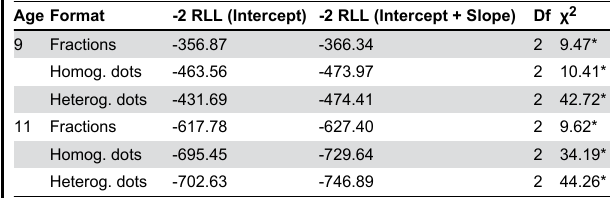
Table 2. Results of likelihood ratio tests comparing the fitting of the model including both the intercept and the slope as random factors with the fitting of the model including only the